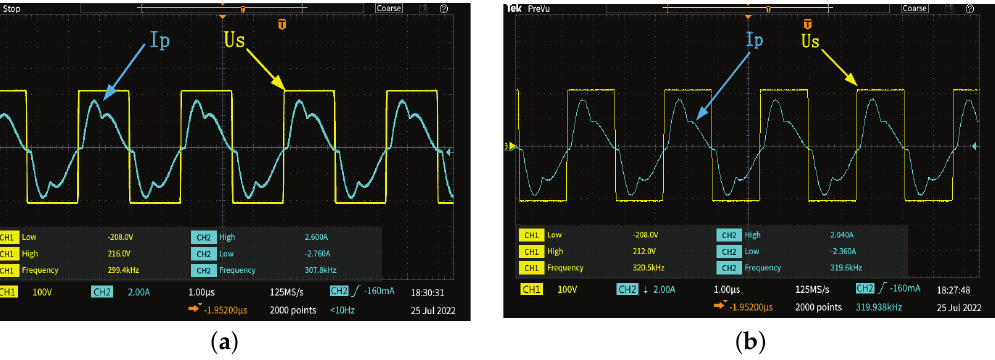
Figure 7. Voltage and current waveforms at inverter output under different frequencies. ( a ) f = 300 kHz. ( b ) f = 320